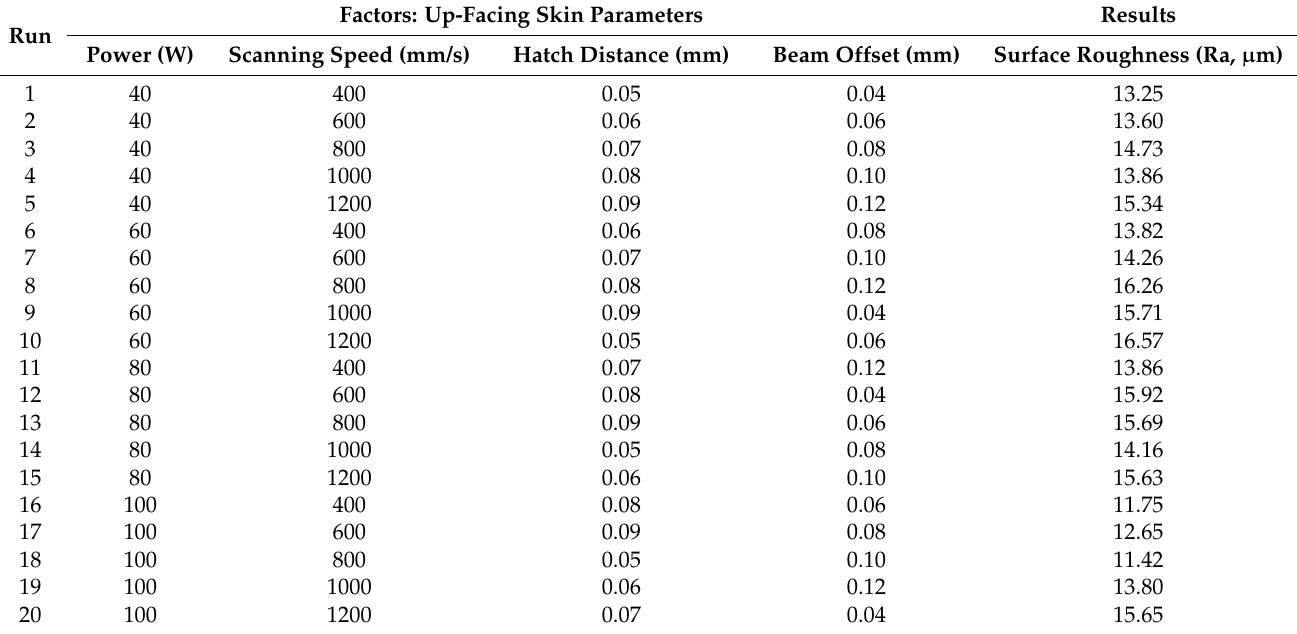
Table 4. L 25 (5 4 ) orthogonal test and experimental results of up-facing skin